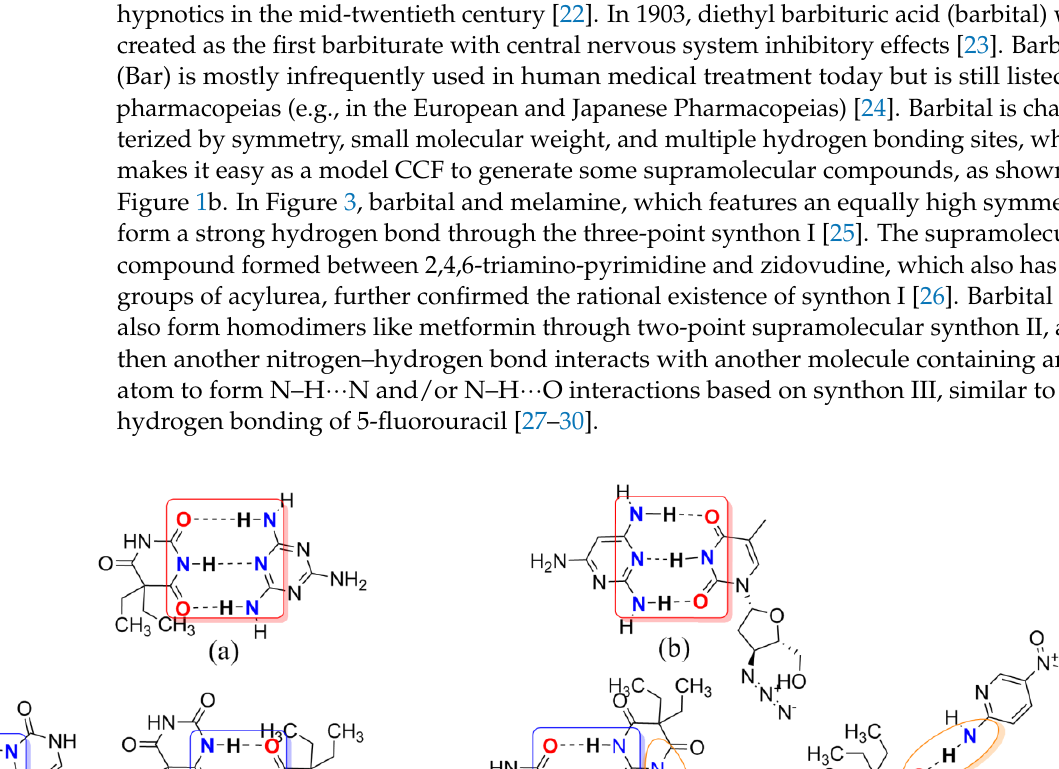
Figure 3 . Several examples of multicomponent chemical structures: ( a ) melamine barbital; ( b ) bis(zidovudine) 2,4,6-triaminopyrimidine; ( c ) 4-amino-2-oxopyrimidine 2,4-dioxo-5-fluoropyrimidine; ( d ) bis(barbital)–caffeine complex; ( e ) bis(barbital) 1-methylimidazole; ( f ) 5,5-diethylpyrimidine-2,4,6(1 H ,3 H ,5 H )-trione bis(5-nitropyridin-2-amine). Supramolecular homo-and/or heterosynthons I, II, and III are highlighted with red, blue, and orange boxes, respectively.